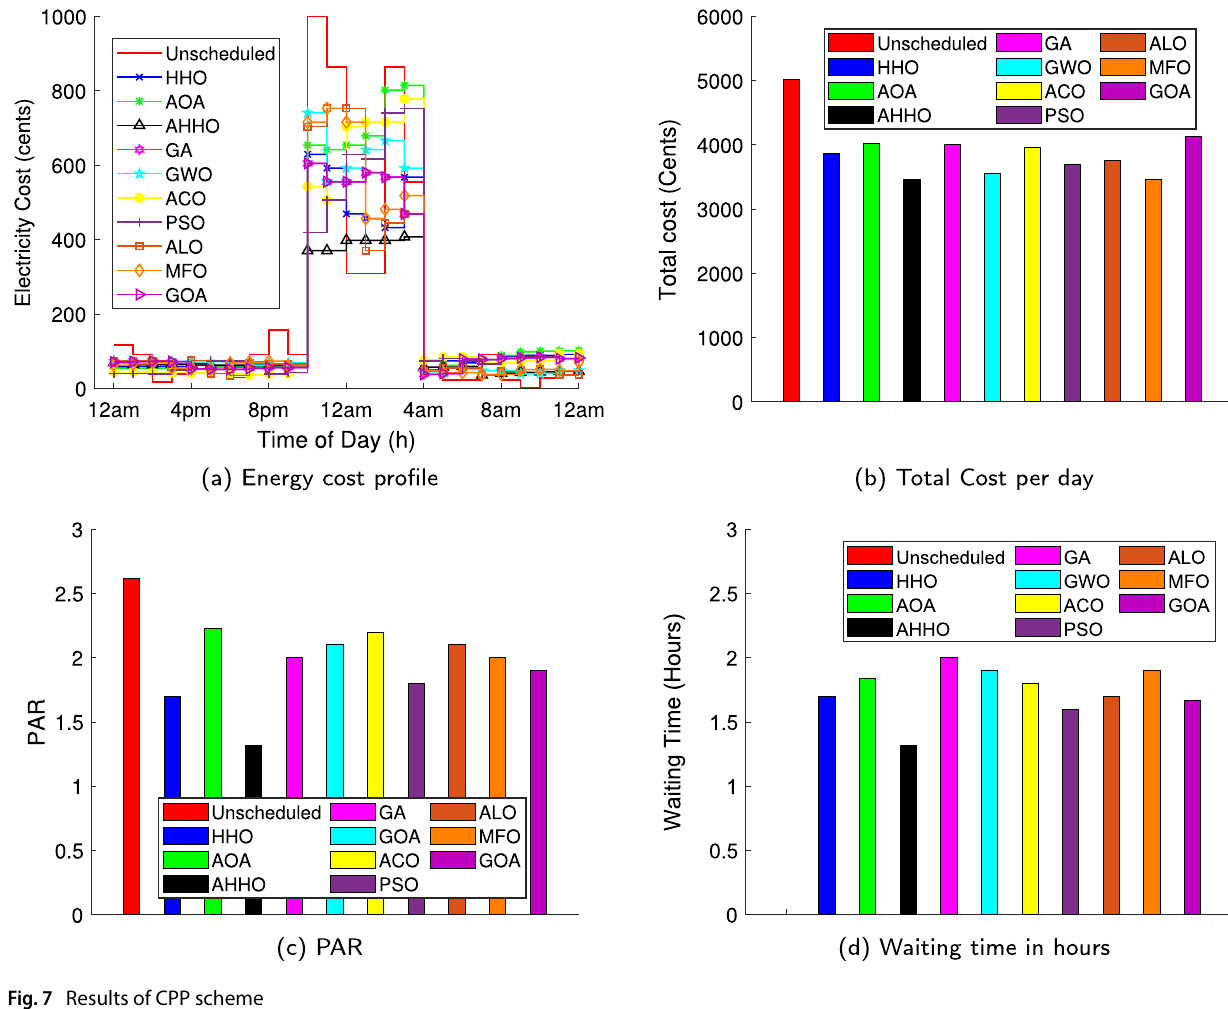
Fig. 7 Results of CPP